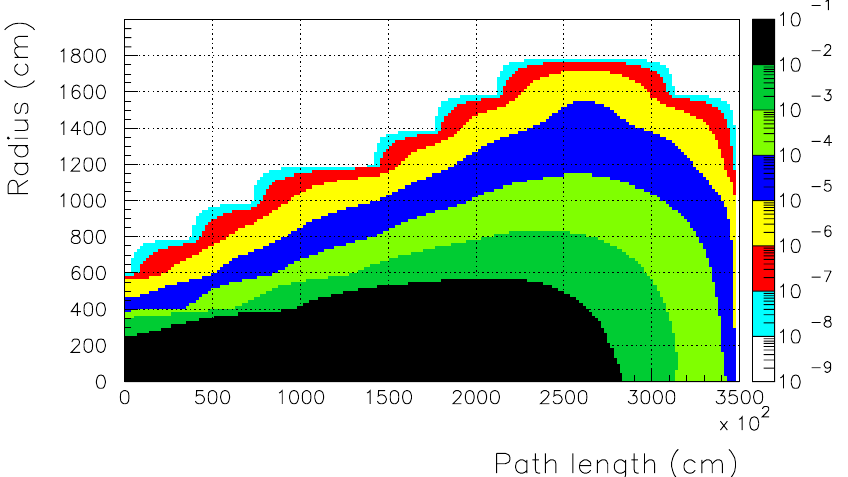
FIG. 60. (Color) Isodose contours in the soil/rock ( r (cid:1) 2.24 g (cid:1) cm 3 ) for 2 TeV muons extracted at 3 3 10 13 per second. Right- hand scale is dose rate in rem (cid:1) s.